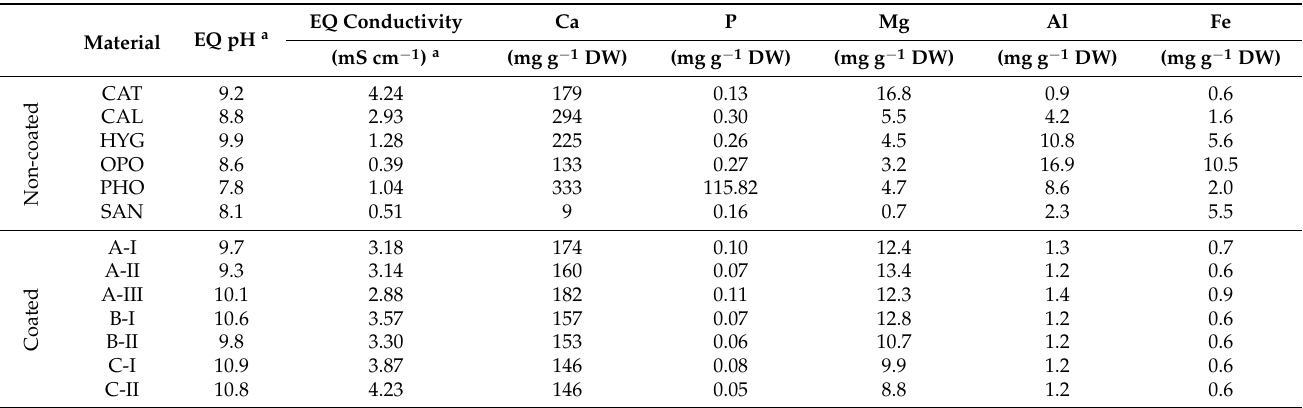
Table 4. Chemical characteristics for non-coated and coated materials. Equilibrium (EQ) pH and conductivity, and the mineral concentration of Al, P, Fe, Ca, and Mg. Values are means of triplicates ( n =